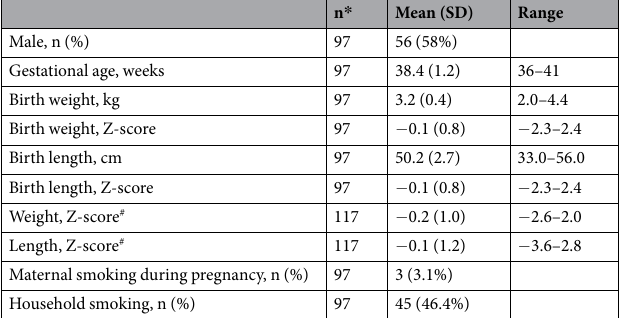
Table 1. Demographic characteristics of 97 infants who underwent 117 lung function tests. Data are expressed as the frequency (%) or mean (SD), unless otherwise stated. * n describes the number of participants or test occasions. # Body weight and length were obtained during testing.